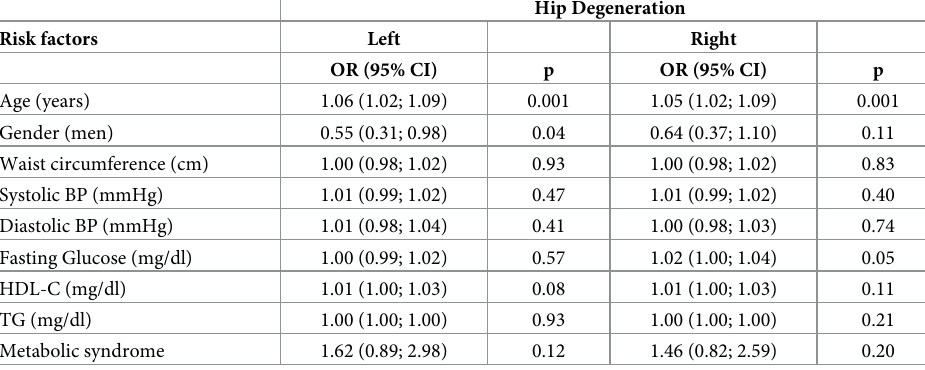
Table 2. Unadjusted ORs (95% CI) for associations of continuous individual metabolic syndrome components with hip